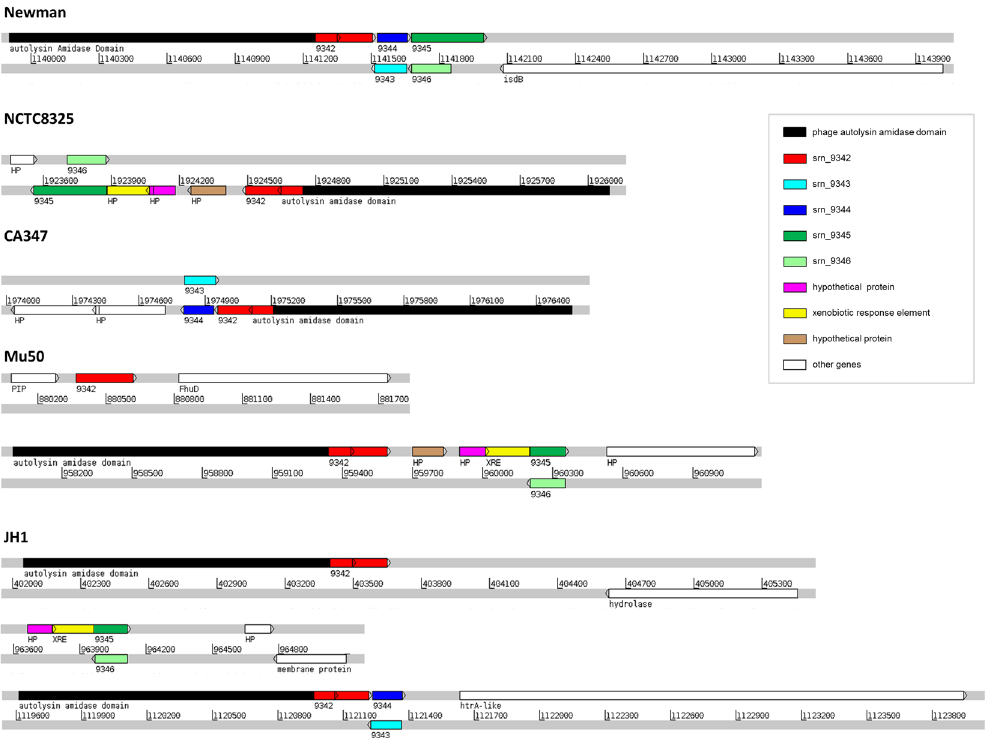
Figure 5. Comparative genomics of the genetic organization of the srn_9342–9346 cluster. The genetic organization of the srn9342 – 9346 locus from Staphylococcus aureus Newman strain was compared with that of the NCTC8325, CA347, Mu50, and JH1